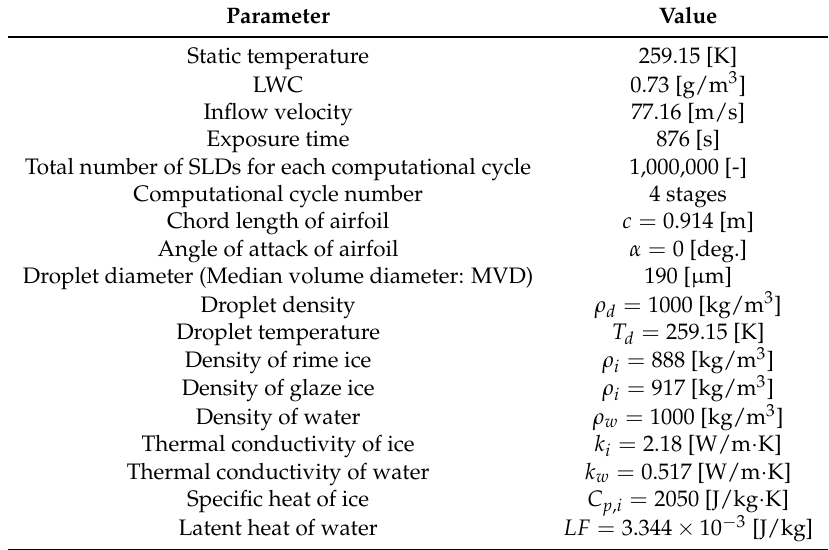
Table 1. Numerical conditions for the NACA0012 icing simulation.